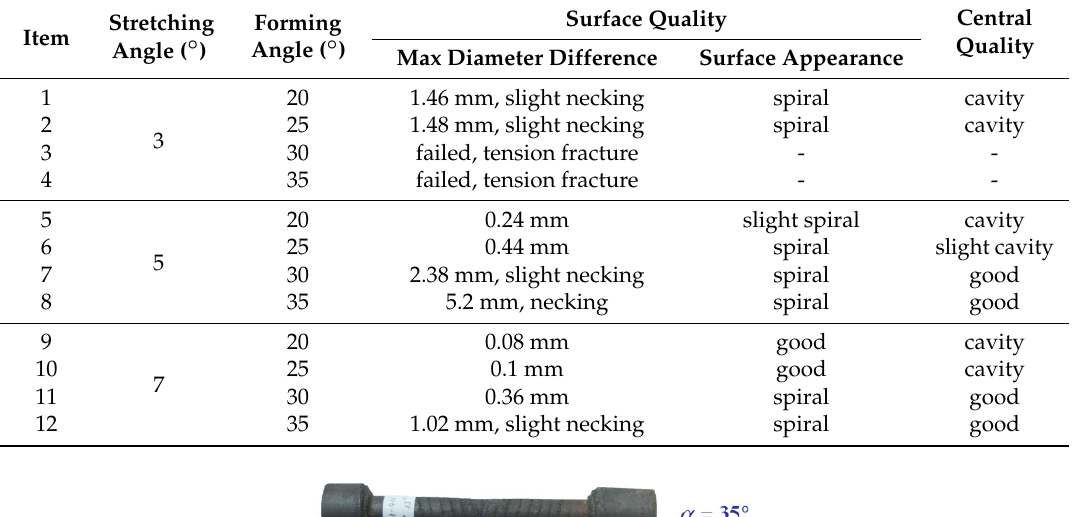
Table 4. Rolling results at various roller parameters.